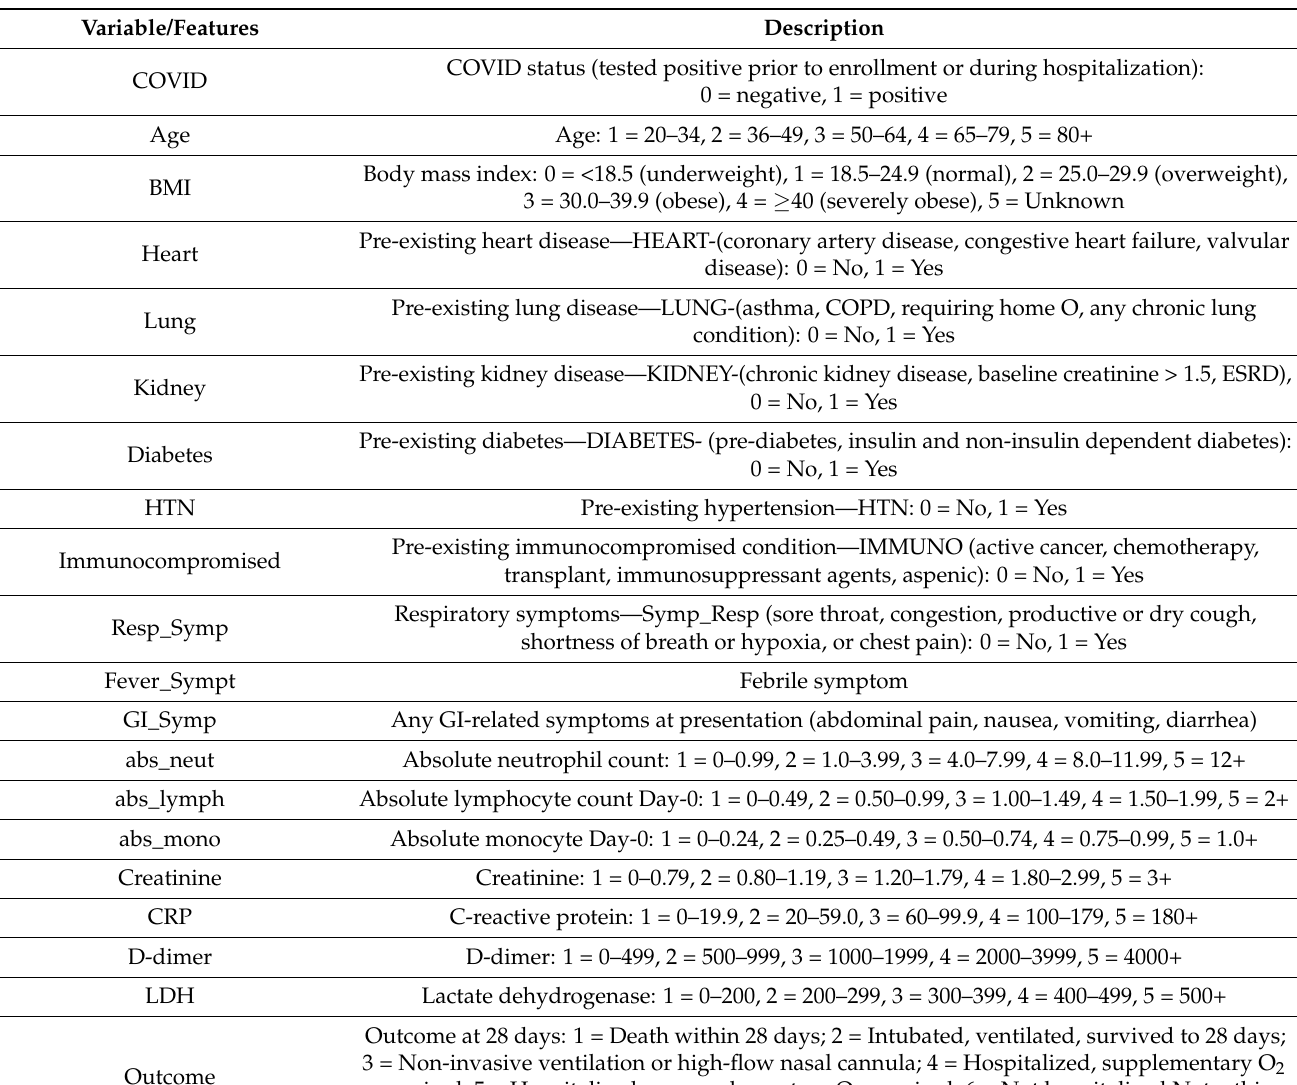
Table 1. Description of different variables in the